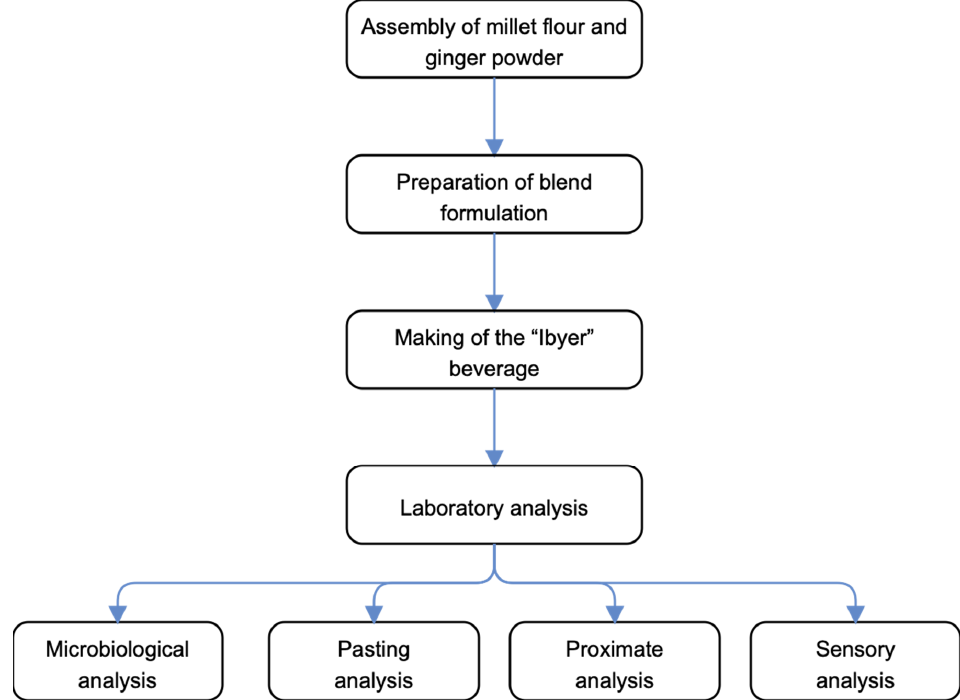
Figure 1. Schematic overview of the experimental program, demonstrating the key/major stages from the assembly and making of both fermented millet flour, together with the ginger powder, through blend formulation to make the “ ibyer ” beverage, and the laboratory analyses.